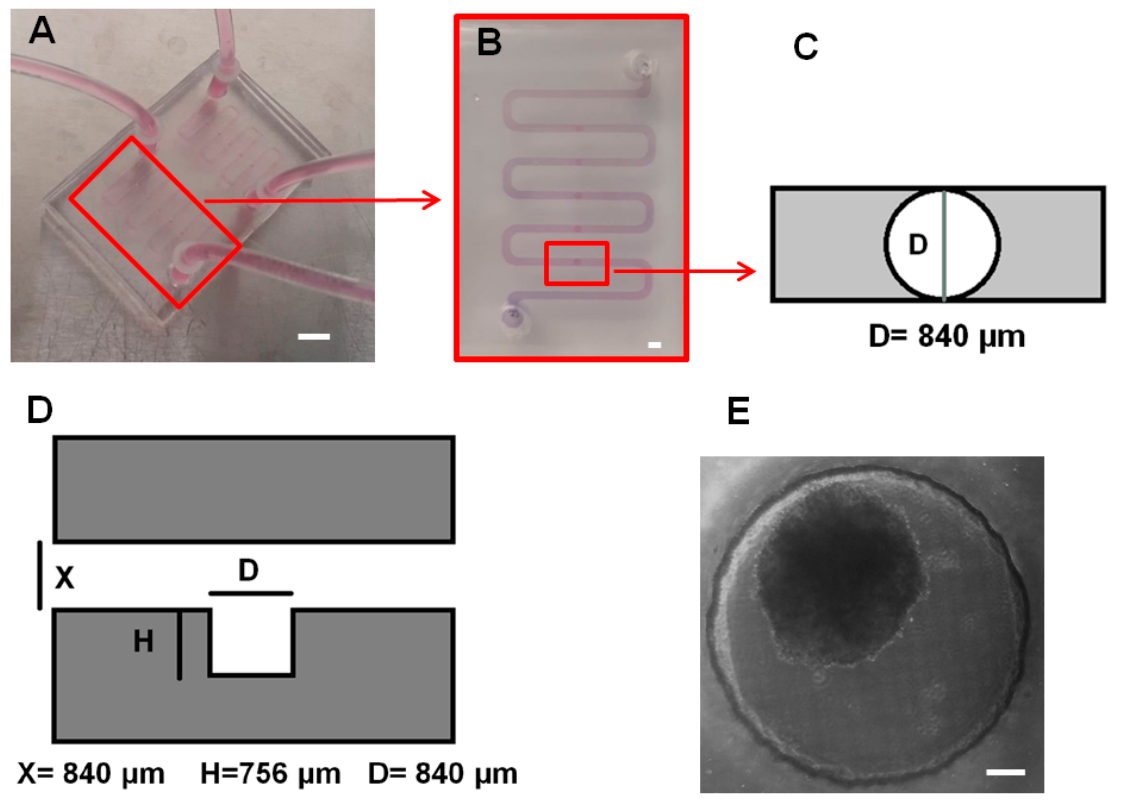
Figure 1. Microfluidic biochip design and spheroid formed in a cylindrical cell-trapping chamber. ( A ) Image of two layers of the PDMS microfluidic device fabricated by the soft lithography tech- nique. Each device has two independent channels of 109.2 mm in length with a cross section of 840 × 840 µm. Each channel has five cylindrical cell-trapping chambers for cell sedimentation and spheroid formation. The error bar represents 1 cm. ( B ) Top view image of a single channel with inlet, outlet, and five cylindrical cell-trapping chambers. The error bar represents 1 mm. ( C ) Schematic of the top view of the cylindrical cell sedimentation trap. The diameter is 840 µm. ( D ) Side view schematic of the cell-trapping chamber. The diameter of the cylindrical chamber is 840 µm, and the height of the chamber is 756 µm. X represents the size of the cross-section of the channel, which is 840 µm. ( E ) Microscopic image from day five of a lung tumor (A549) spheroid formed in the cell-trapping chamber. The scale bar represents 100 µm.